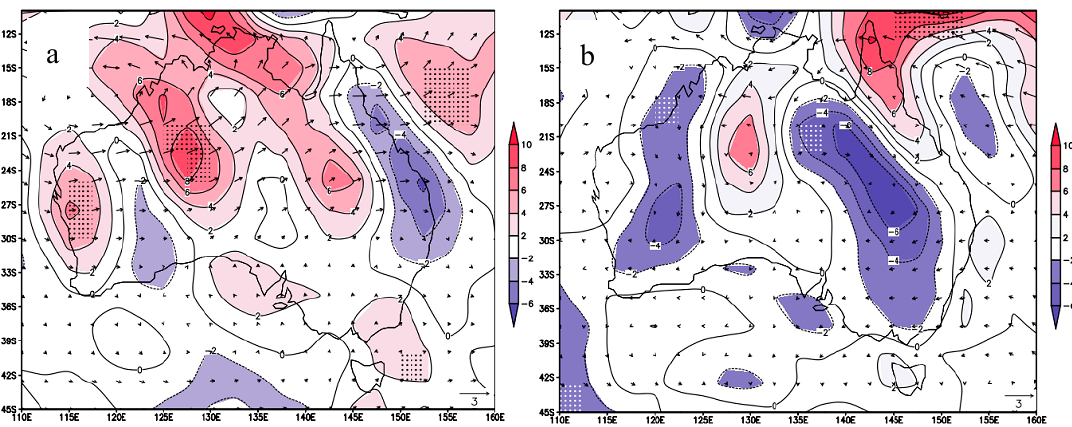
Figure 9. Composite water vapor flux anomaly at 850 hPa (vectors; units: g·cm − 1 ·hPa − 1 ·s − 1 ) and its divergence (contours; units: 10 − 7 g·cm − 2 ·hPa − 1 ·s − 1 ) in the austral ( a ) autumn and ( b ) winter El Niño events. Dotted areas indicate statistical significance at the 95% confidence level, based on the Student’s t -test.